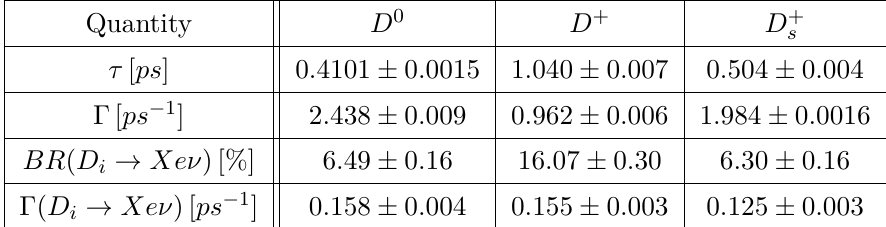
Table 1. Summary of measured values for the lifetimes and semileptonic branching fractions of charmed mesons. The quoted values are the latest PDG averages [21], with the exception of BR ( D s → Xeν ) , for which we show the recent result by BESIII [46]. We combine the statistical and systematic errors in quadrature in cases where both are given by experimental collaborations. A recent Belle II measurement [47] is compatible with the world